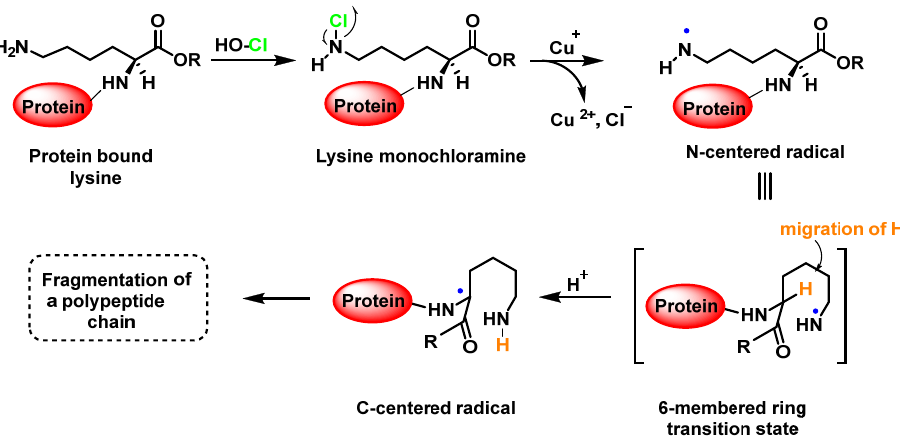
Figure 35. Formation of the radical centred on the N of Lys with subsequent transformation to a C-centred radical.